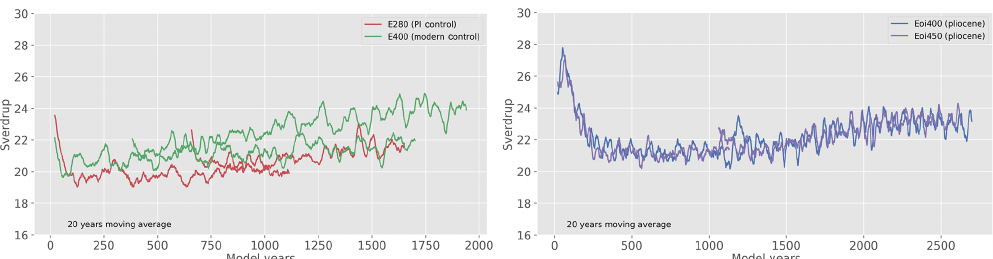
Figure 14. Evolution of the maximum strength of the Atlantic Meridional Overturning Circulation. The results shown have been filtered with a 20-year running mean to remove high-frequency variability. For each simulation, the curve that starts at model year zero is for the version that uses a vertically constant background diapycnal diffusivity, while the curve with identical color that starts midway is for the version that uses the CCSM3/POP1 type vertical profile of diapycnal diffusivity.